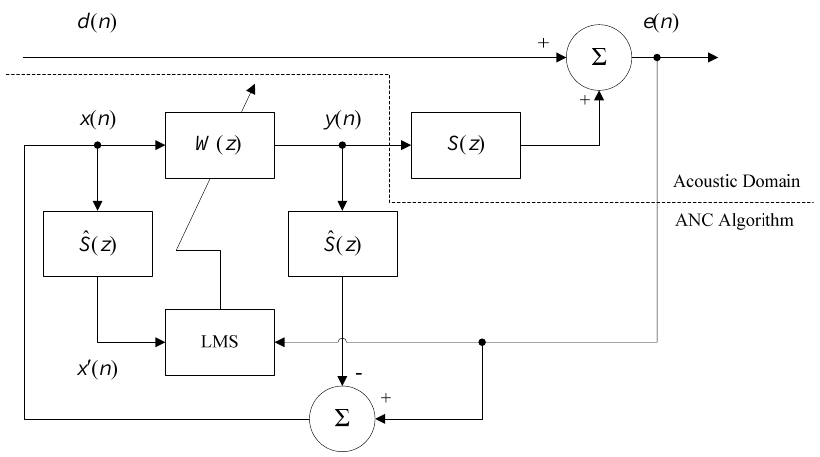
Figure 2. Feedback ANC algorithm.